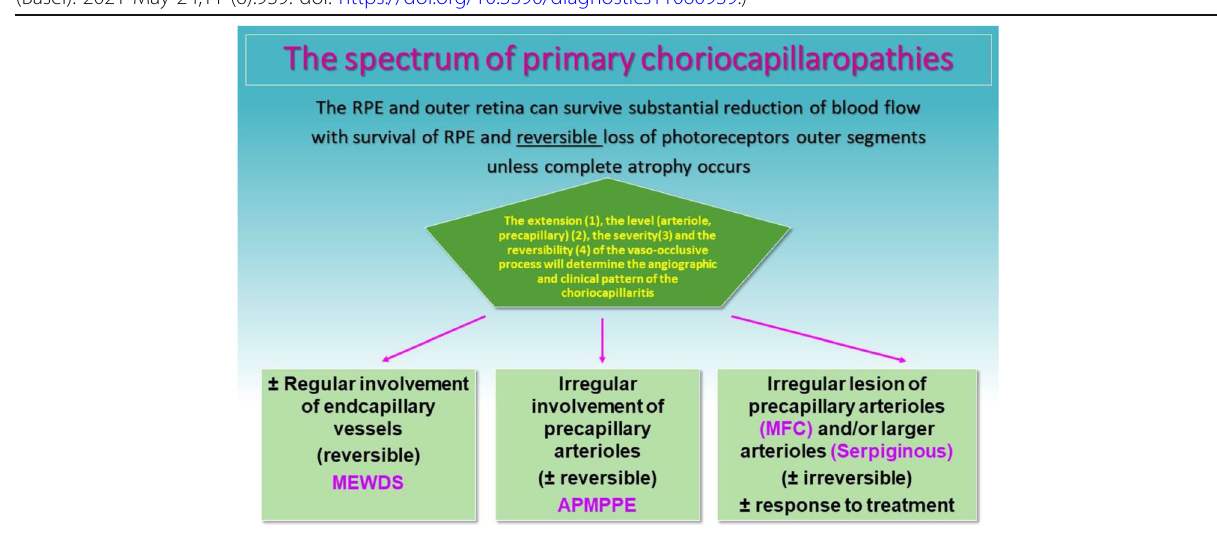
Table 2 Schematic classification of PICCPs according to suspected location of vaso-occlusive event. (Adapted from “ Diagnostics